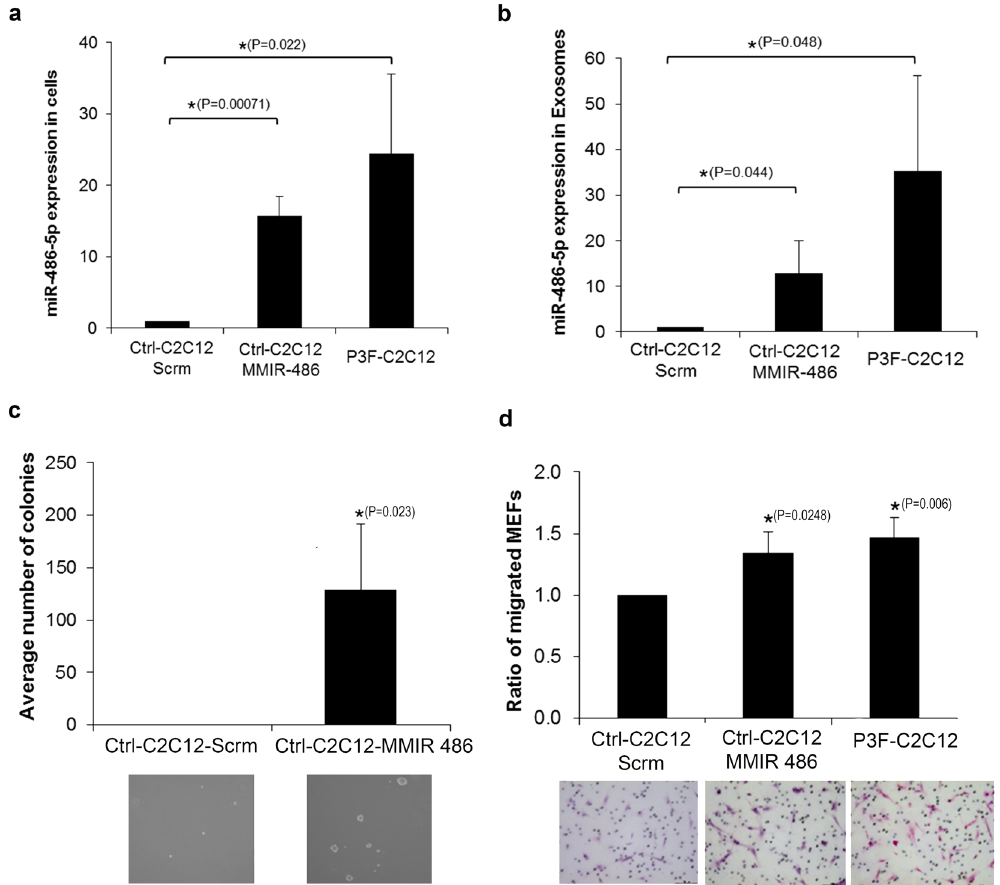
Figure 5. Overexpressing miR-486-5p in C2C12 cells leads to exosome effects mimicking those of PAX3- FOXO1 expression. ( a , b ) qRT-PCR analysis of miR-486-5p expression in ( a ) C2C12 cells and ( b ) their derived exosomes, after transduction with either negative control vector (Scrm) or miR-486-5p overexpressing vector (MMIR-486). Values are normalized to Ctrl-C2C12-Scrm cells and their derived exosomes. ( c ) Colony formation assay of C2C12 cells transduced with either Scrm or MMIR-486, as indicated. ( d ) Ratio of migratory MEFs after treatment with the specified exosomes at 10X for 24 hours. Values presented are means of three independent experiments. Bars represent standard deviation. Asterisks denote a statistically significant difference (p-value <